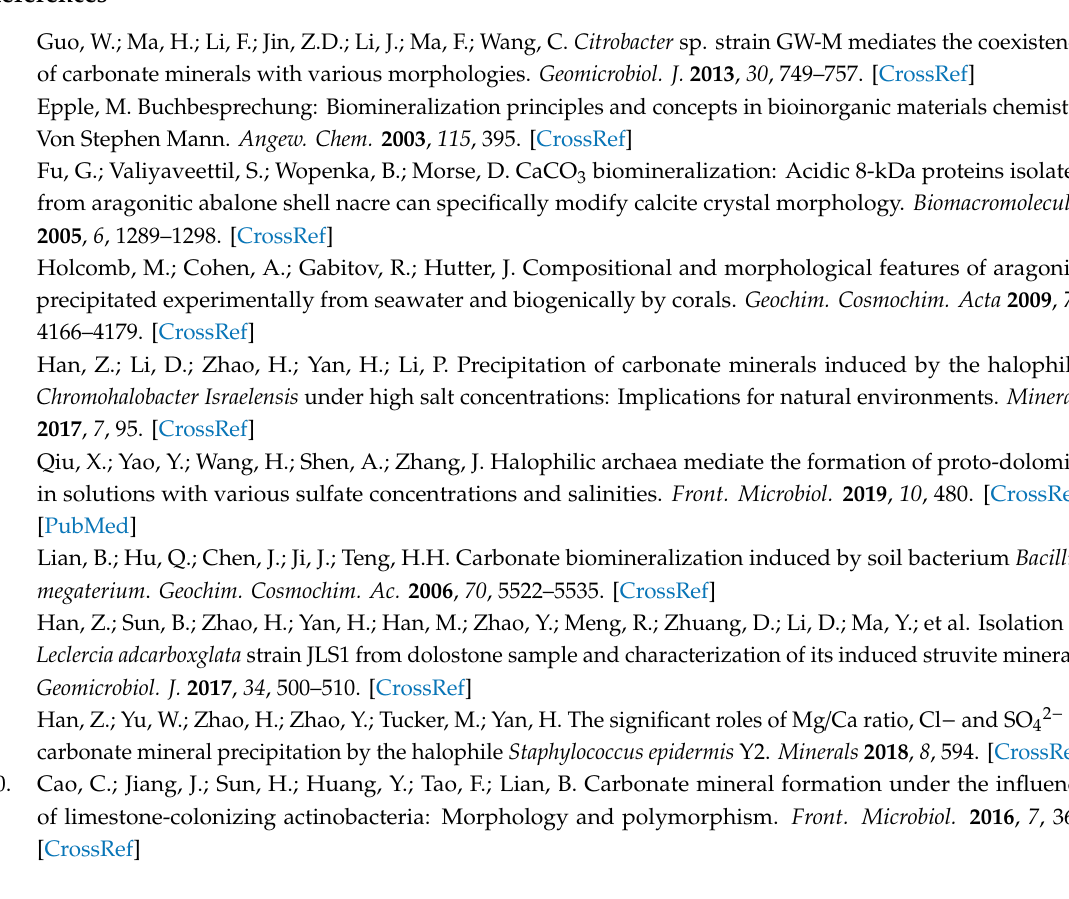
Table S1. Mineral phases and crystal parameters of minerals in the experimental groups. Table S2. Crystal parameters of the abiotic and biotic aragonite (Mg / Ca = 8). Table S3. Parameters of molecular dynamic simulation for the adsorption of Glu onto aragonite surfaces. Figure S1. The phylogenetic tree of YXY2. Figure S2. Ammonia cultivated for 14 days (a, b, c, d, and e represent minerals at Mg / Ca molar ratios of 0, 2, 4, 6, and 8, respectively). Figure S4. Mg content within the biotic and abiotic aragonite measured using flame atomic absorption